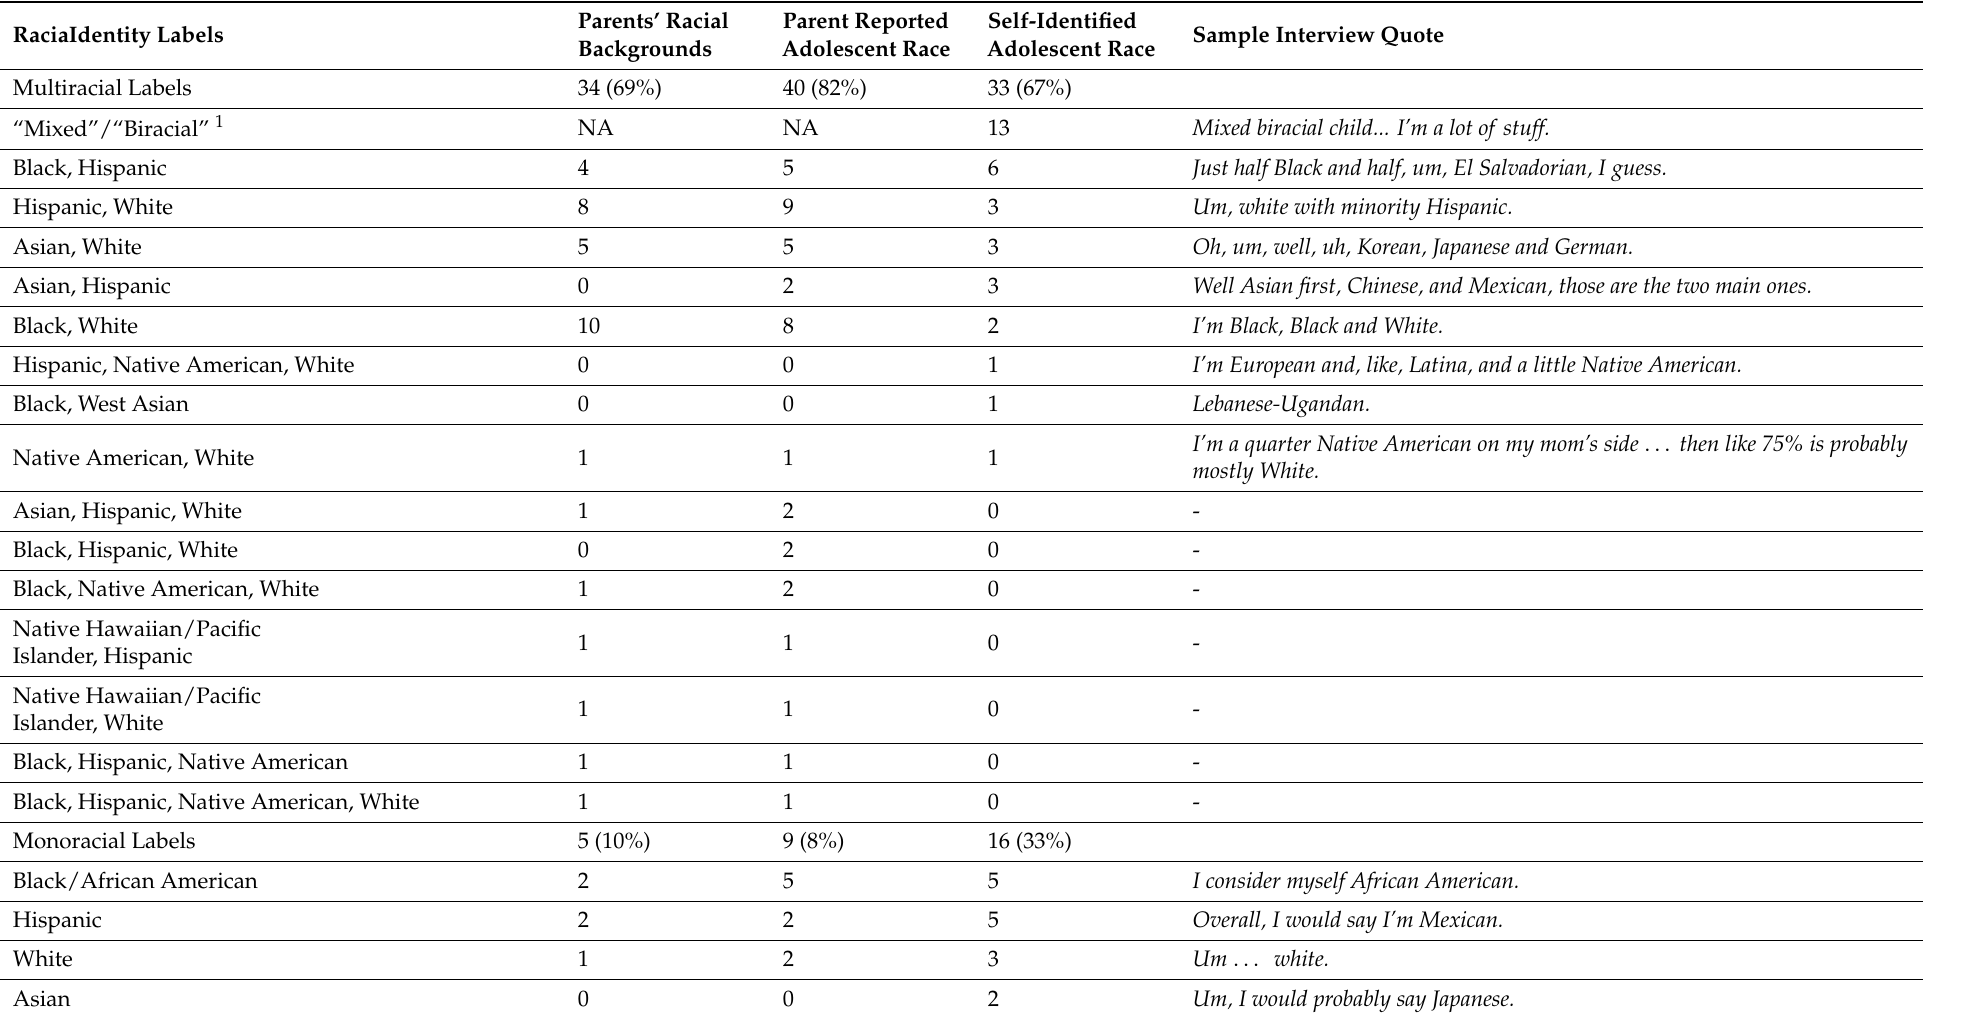
Table 1. Racial identity for the full sample. This includes a sample breakdown by parents’ combined racial backgrounds, parent-reported adolescent race, and self-identified adolescent